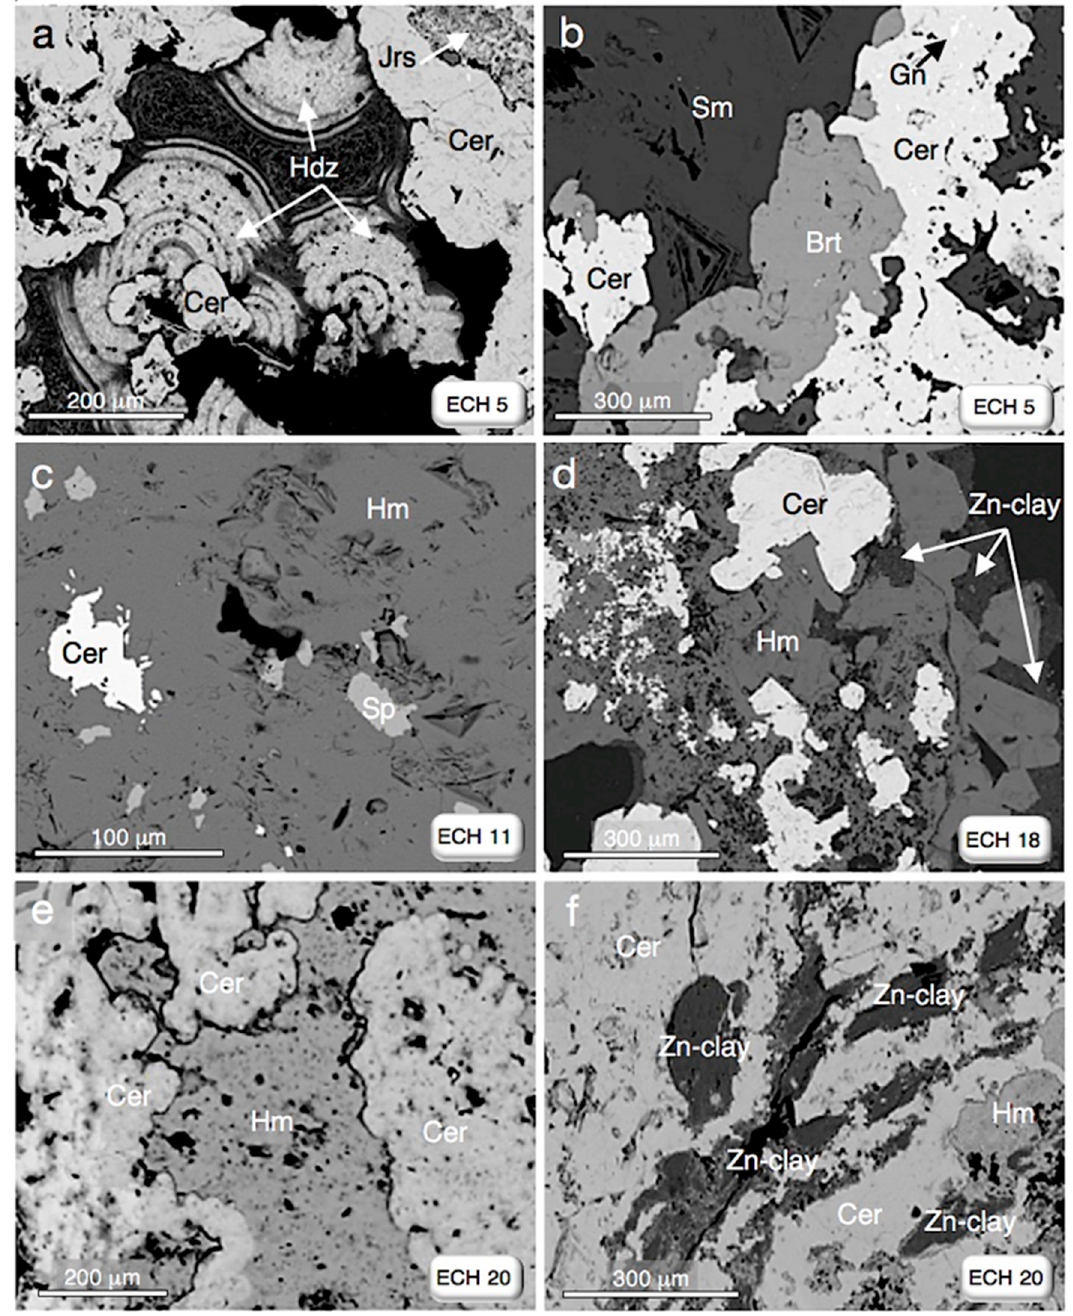
Figure 8. SEM-BSE micrographs of selected Bou Caïd samples. ( a ) Hydrozincite as cavity linings among cerussite crystals, with late jarosite; ( b ) galena remnants in cerussite, with smithsonite and barite; ( c ) hemimorphite and cerussite, with remnants of sphalerite; ( d ) euhedral hemimorphite crystals and cerussite, with late Zn-clays; ( e ) cerussite with hemimorphite fillings; ( f ) cerussite and minor hemimorphite, permeated by Zn-clays. Brt: barite; Cer: cerussite; Gn: galena; Hm: hemimorphite; Hdz: hydrozincite; Sm: smithsonite; Sp: sphalerite.